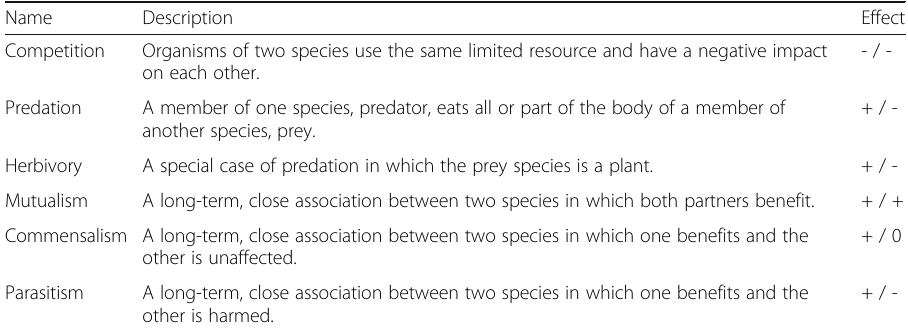
Table 5 The Main Types of Interspecies Interactions in Ecological Communities (Khan Academy